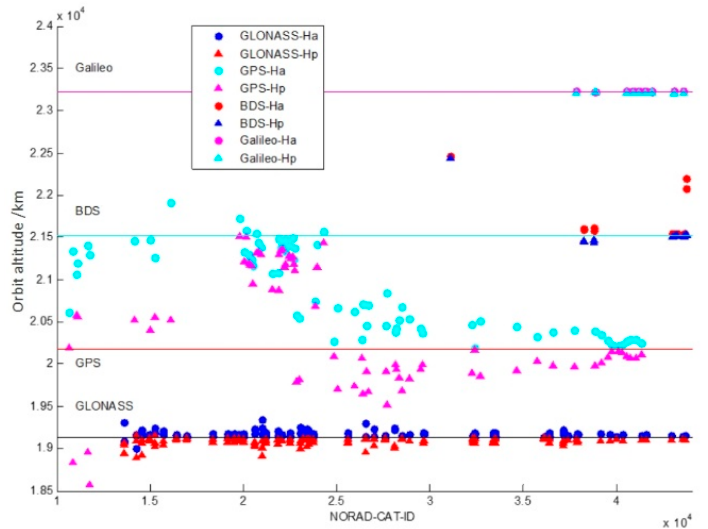
Figure 13. Distributions of navigation satellites in the MEO region. As shown in Figure 13, several disposed GPS satellites have already crossed into the BDS and GLONASS regions and have a peak value of space object density near the BDS operational orbit. Most of the disposed GLONASS are left in the operational orbit; the space object density near the GLONASS operational orbit is relatively large. Figure 14 shows the distributions of spent upper stages.